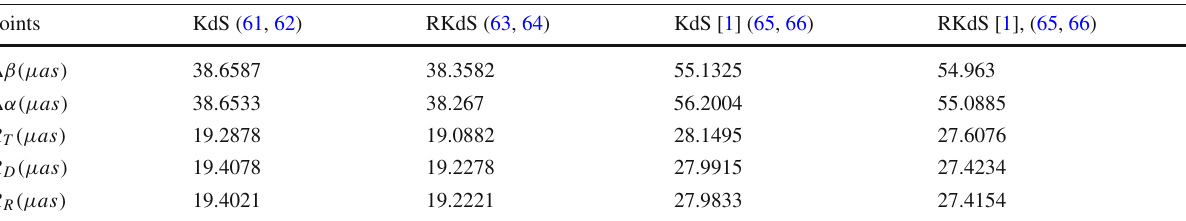
Fig. 9 Plots of a KdS with RKdS black hole shadows with a = 0 . 999, M = 1 . 06 and (cid:2) = 0 . 06 m − 2 for different angles inclination Table 2 Points evaluated for θ = 16 ◦ , a = 0 . 5 and (cid:2) = 0 . 06 m −